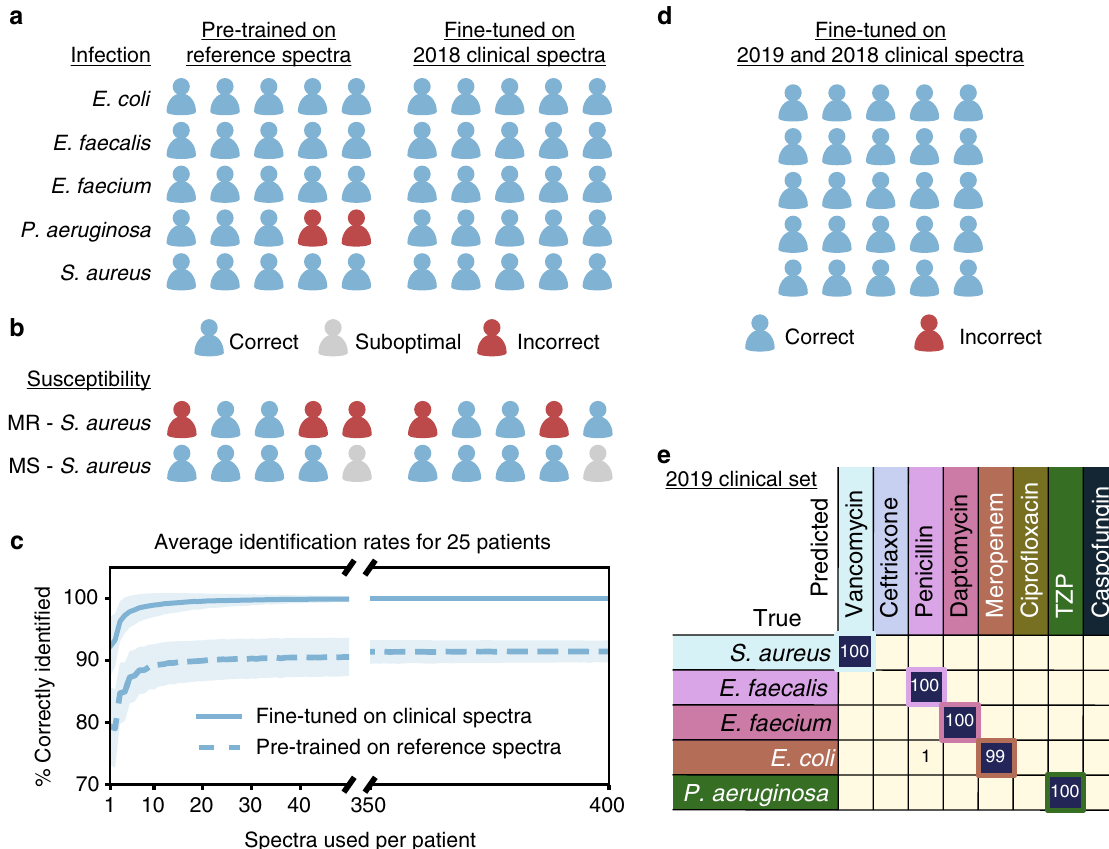
Fig. 4 Extension to clinical patient isolates. A CNN pre-trained on our reference dataset can be extended to classify clinical patient isolates and further improved by fi ne-tuning on a small number of clinical spectra. a 5 species of bacterial infections are tested, with 5 patients per infection type. Each patient is classi fi ed into one of 8 treatment classes where each species corresponds to a different treatment class. After fi ne-tuning, species identi fi cation accuracy improves from 89.0±3.6% to 99.0±1.9% (± calculated as standard deviation across 10,000 sampling trials). b Binary classi fi cation between MRSA and MSSA patient isolates is also performed, with an accuracy of 61.7±7.3% that improves to 65.4±6.3% after fi ne-tuning. c Dependence of average diagnosis rates for the fi ne-tuned model on the number of spectra used per patient. With just 10 spectra, the performance of the model reaches 99% — within 1% difference of the performance with 400 spectra (100%). Error bars are calculated as the standard deviation across 10,000 trials of random selections of n spectra, where n is the number of spectra used per patient. d We perform an additional test on a new clinical dataset gathered from an additional 25 patients with the same distribution across species as the fi rst clinical dataset. We update the model that is pre-trained on the reference dataset and fi ne- tuned on the fi rst clinical dataset by fi ne-tuning on the second clinical dataset using the same procedure. e Detailed breakdown by class for the second clinical dataset. Correct pairings between species and treatment group are outlined in the colored boxes. The rate of accurate identi fi cation is